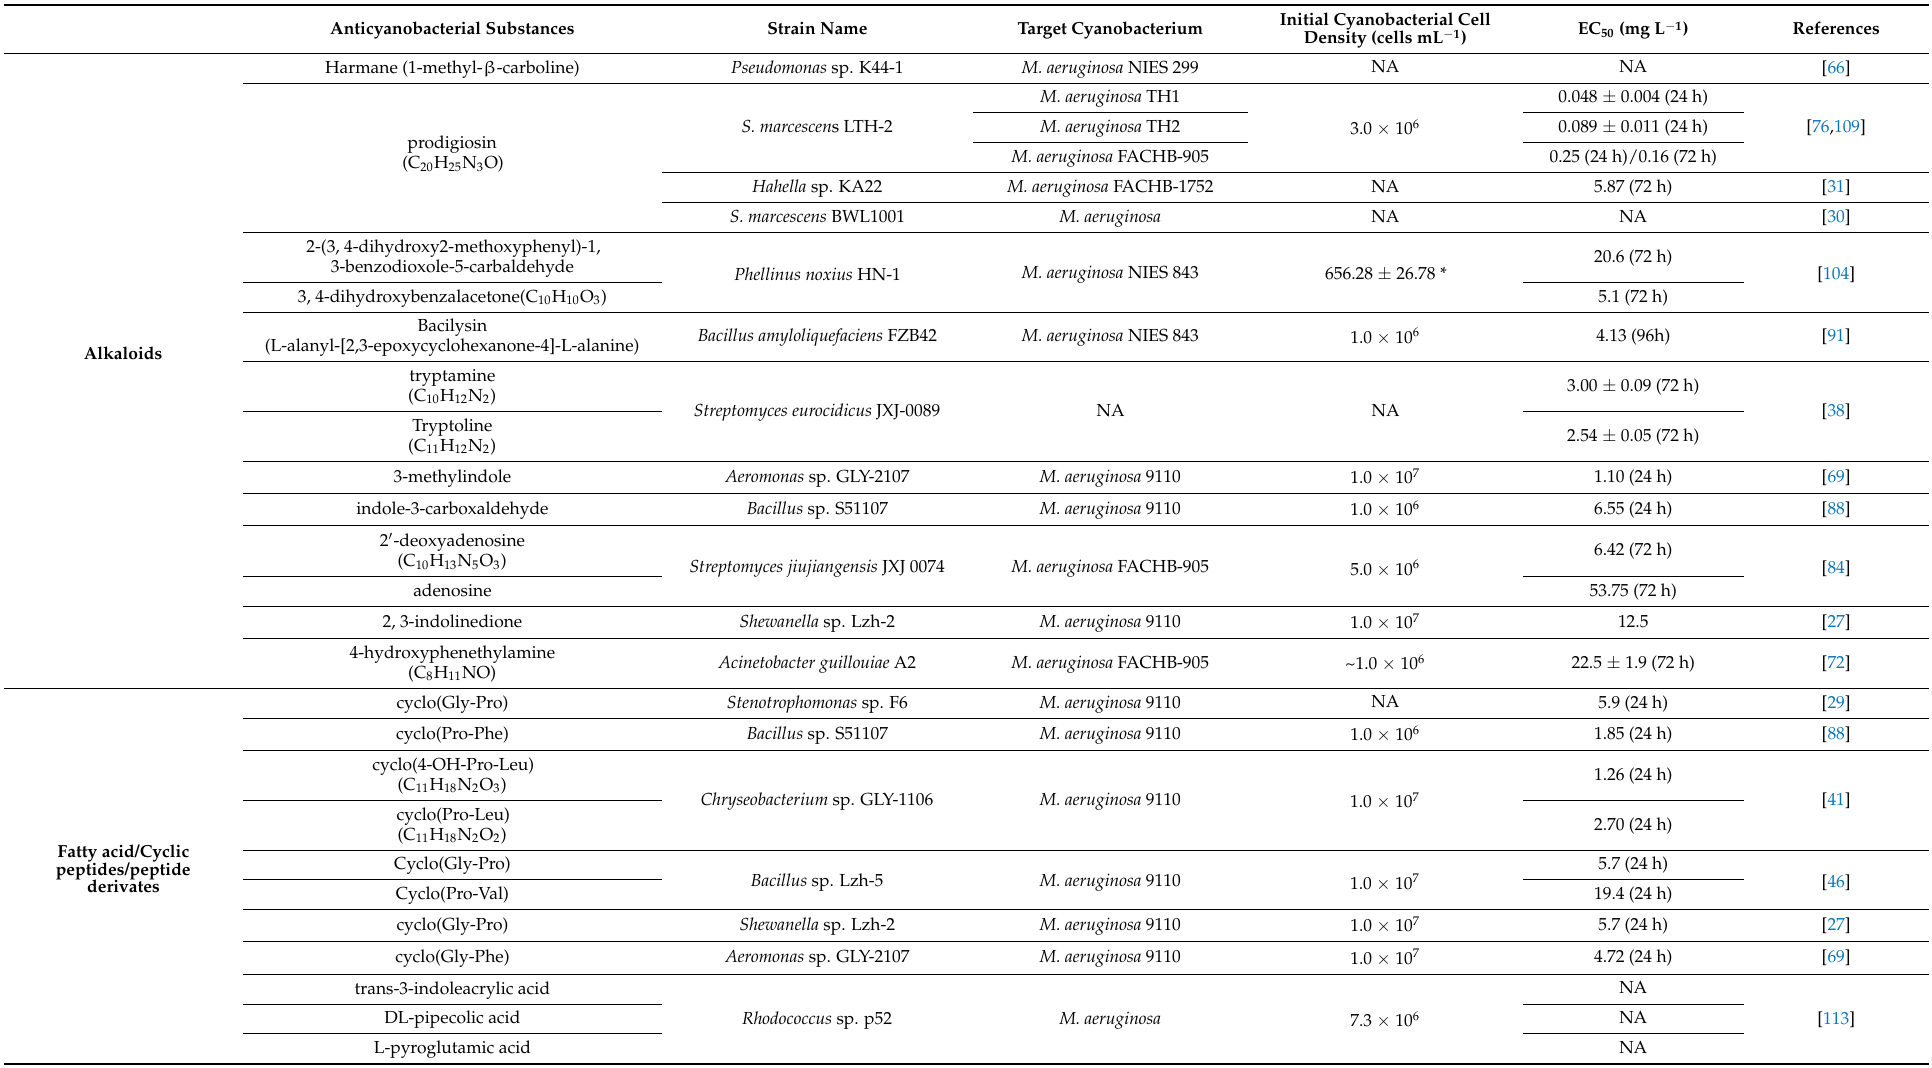
Table 2. Anticyanobacterial substances and their EC 50 on M. aeruginosa